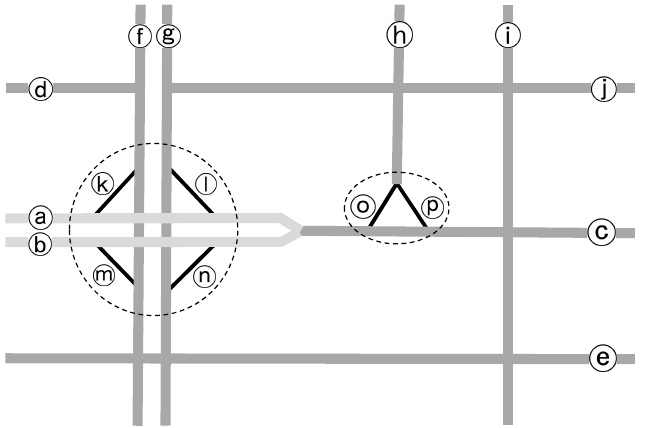
Figure 1. A schematic road network T for illustrating primary roads, secondary roads, and complex